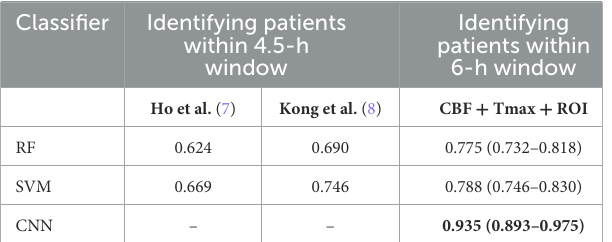
TABLE 5 The AUCs of classifiers of the identification of patients with AIS within a 6- and 4.5-h